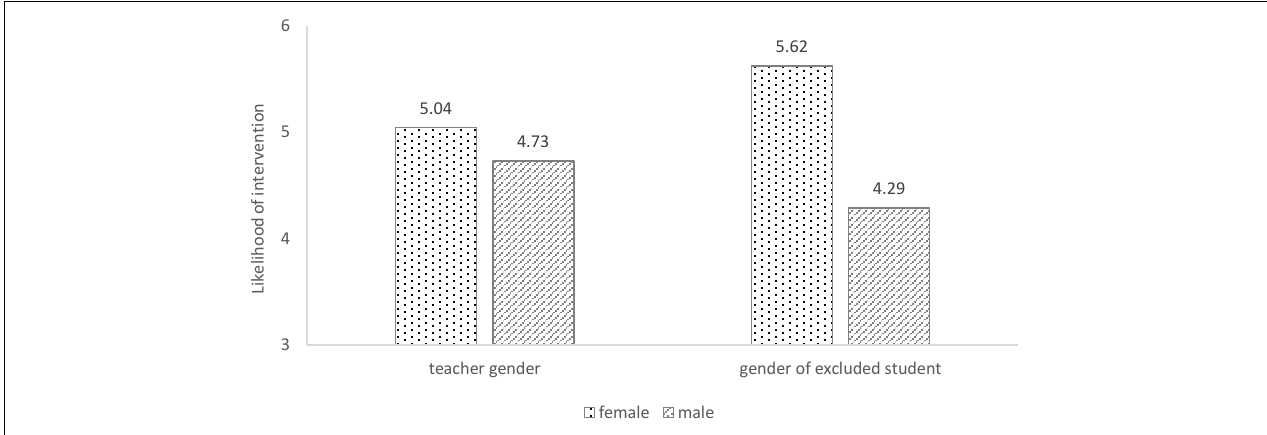
FIGURE 2 | Likelihood of intervention as a function of teacher gender and the gender of the excluded student. High numbers indicate high likelihood to intervene; low numbers indicate low likelihood to intervene.